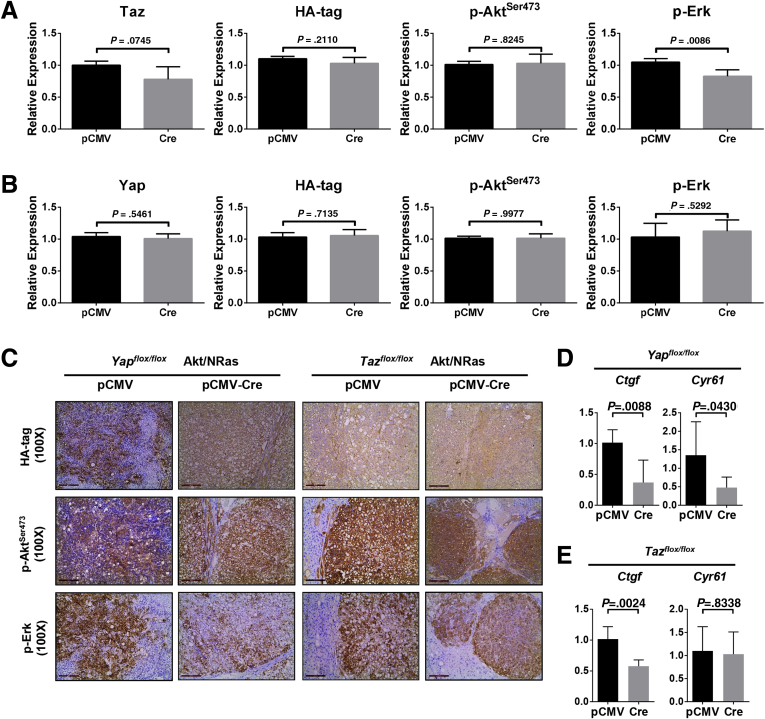
Molecular biological analysis of Yap or Taz-depleted Akt/NRas liver tumors. (A) Quantification of Taz, HA-tag, p-AktSer473, and p-Erk1/2 expression in Yapflox/flox murine Akt/NRas/pCMV and Akt/NRas/pCMV-Cre liver tumors. (B) Quantification of Yap, HA-tag, p-AktSer473, and p-Erk1/2 expression in Tazflox/flox murine Akt/NRas/pCMV and Akt/NRas/pCMV-Cre liver tumors. (C) Immunohistochemical staining pattern of HA-tagged Akt (upper panel), activation form of Akt (p-AktSer473; middle panel), and Ras downstream target p-Erk (lower panel) in Yapflox/flox and Tazflox/flox murine Akt/NRas liver tumors. Scale bar: 200 μm. (D) Expression of canonical Yap/Taz target genes, Ctgf and Cyr61, in Akt/NRas liver tumors developed in Yapflox/flox or Tazflox/flox conditional knockout mice.